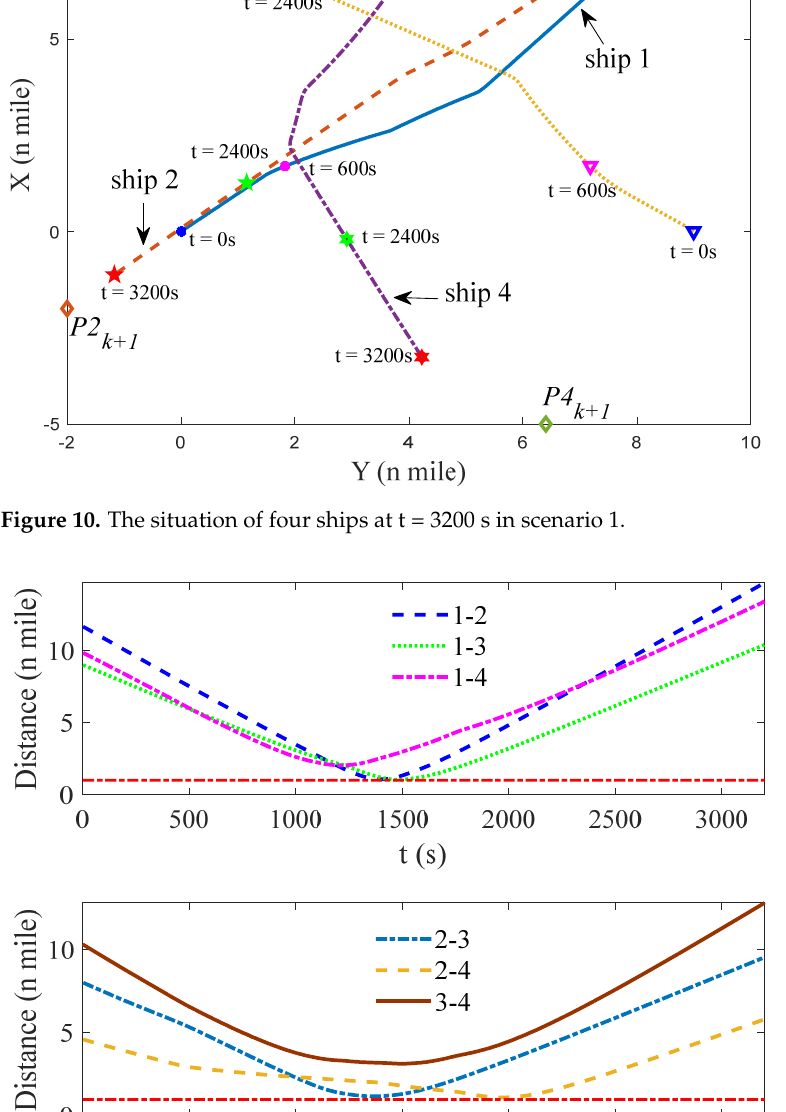
Figure 11. The distance between two ships in scenario 1.